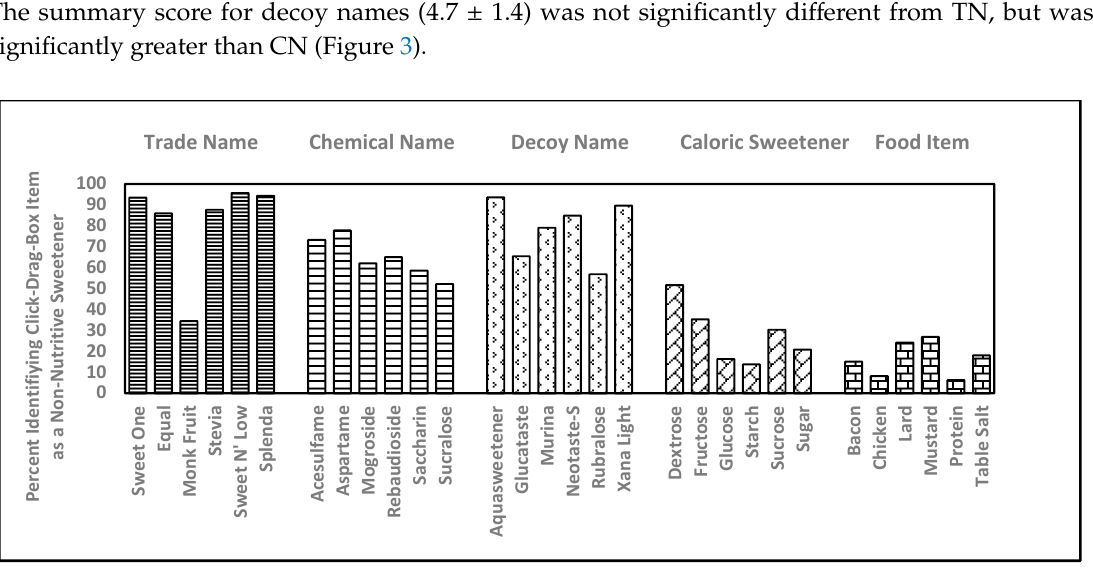
Figure 2. Percentage of respondents identifying 36 click-drag-box items within five categories as being examples of non-nutritive (artificial) sweeteners.